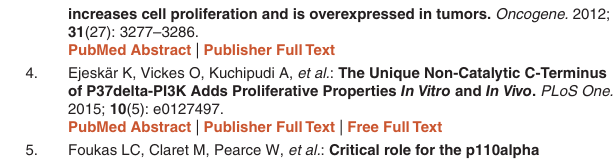
Dataset 4: Raw data for metabolic procedures and measure- ments and gene expression shown in Figure 4. DOI,